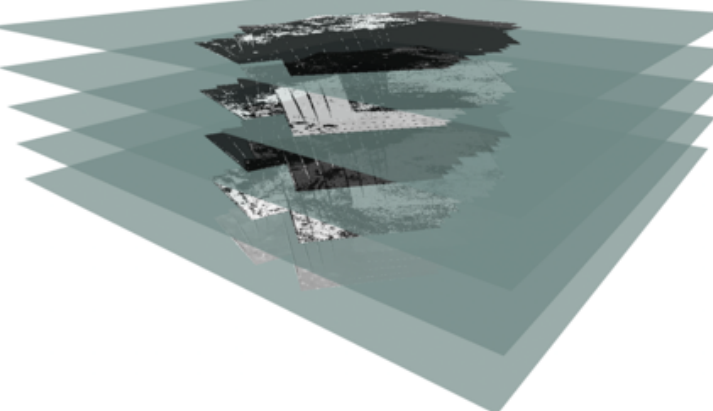
Figure 20. ROS map result of the four distinct classified terrain types into layers (1st layer- water; 2nd layer- vegetation; 3rd layer- asphalt; 4th layer- sand; 5th layer- images by RGB camera). Georeferenced map visualization using RViz tool.